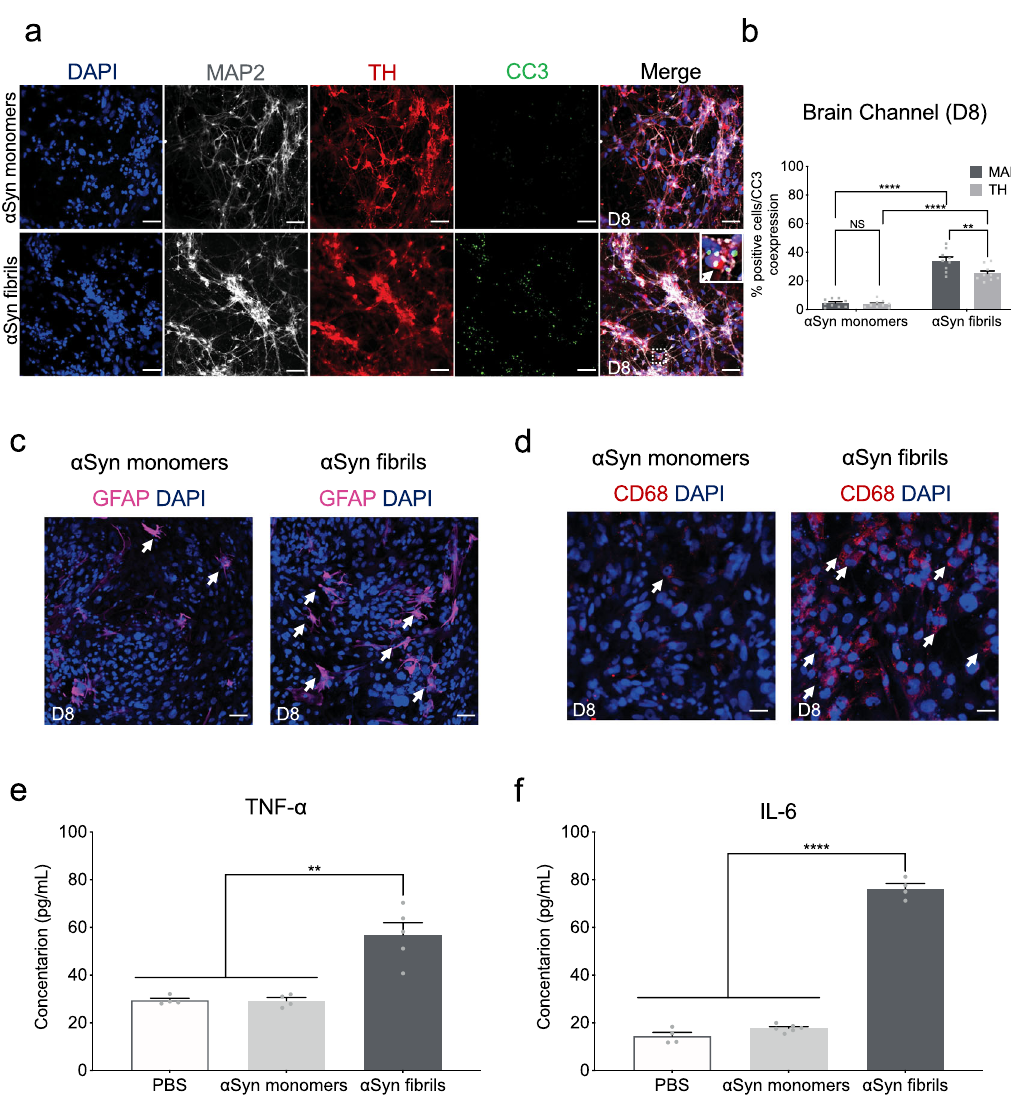
Fig. 5 α Syn-induced caspase-3 activation and neuroin fl ammation. a Representative merged images showing immunostaining for microtubule-associated protein 2 (gray, MAP2), tyrosine hydroxylase (red, TH), and Cleaved Caspase-3 (green, CC3) in the brain channel at 6-days post-exposure to α Syn fi brils or α Syn monomers. Scale bars: 100 μ m. b Quantitation of the number of CC3 and MAP2- or TH-positive neurons. Statistical analysis by two-way ANOVA with Tukey ’ s multiple comparisons test (3 – 4 randomly selected different areas per chip, n = 3 independent chips/experimental group, ** P = 0.0033, **** P < 0.0001, NS not signi fi cant). Error bars represent mean ± SEM. Scale bars: 100 μ m. c Immunostaining of the astrocyte marker glial fi brillary acidic protein (magenta, GFAP) demonstrated activation of astrocytes (white arrow) at day 6 post exposure to α Syn fi brils compared to monomeric α Syn. Scale bar, 100 μ m. d Immunostaining of the microglial CD68 (red) demonstrated activation of microglia (white arrow) at day 6 post exposure to α Syn fi brils compared to monomeric α Syn. Scale bar, 100 μ m. e The secreted levels of tumor necrosis factor-alpha (TNF- α ) in the α Syn fi bril model. Statistical analysis is two-sided unpaired t -test ( n = 6 – 7 independent chips, ** P = 0.0023). Error bars represent mean ± SEM. f The secreted levels of proin fl ammatory cytokine interleukin-6 (IL-6) in the α Syn fi bril model. Statistical analysis is two-sided unpaired t -test ( n = 4 – 7 independent chips, **** P < 0.0001). Error bars represent mean ±